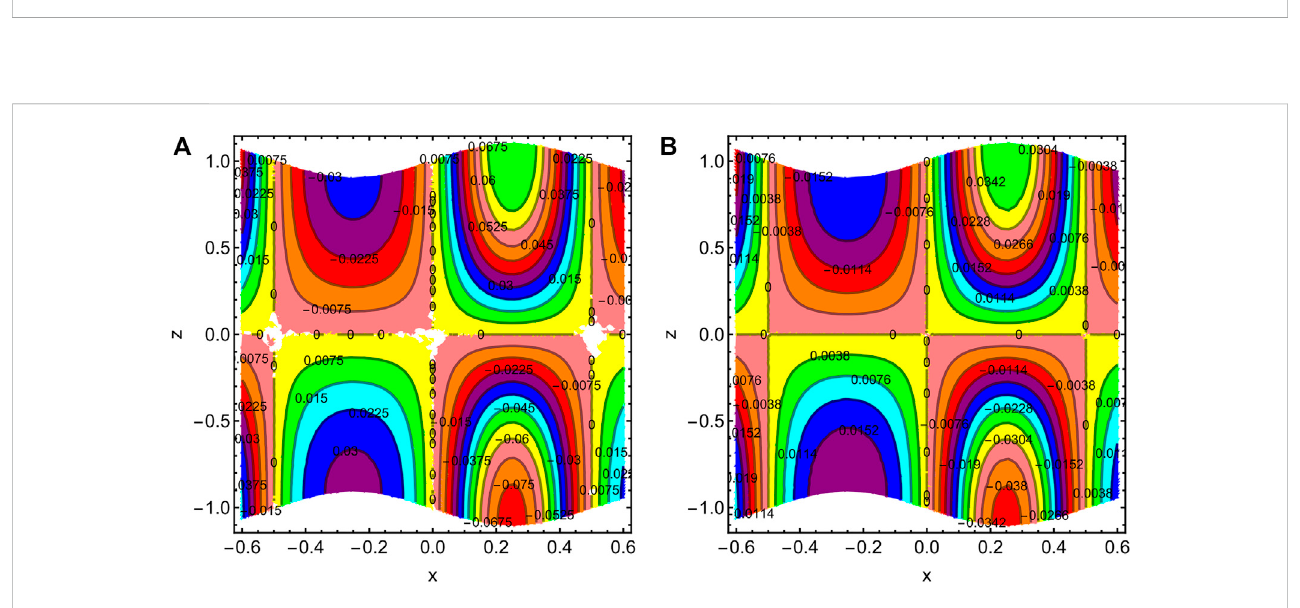
FIGURE 5 (A, B). Stream lines of u f for various values of M = 1.0 and 2.0.